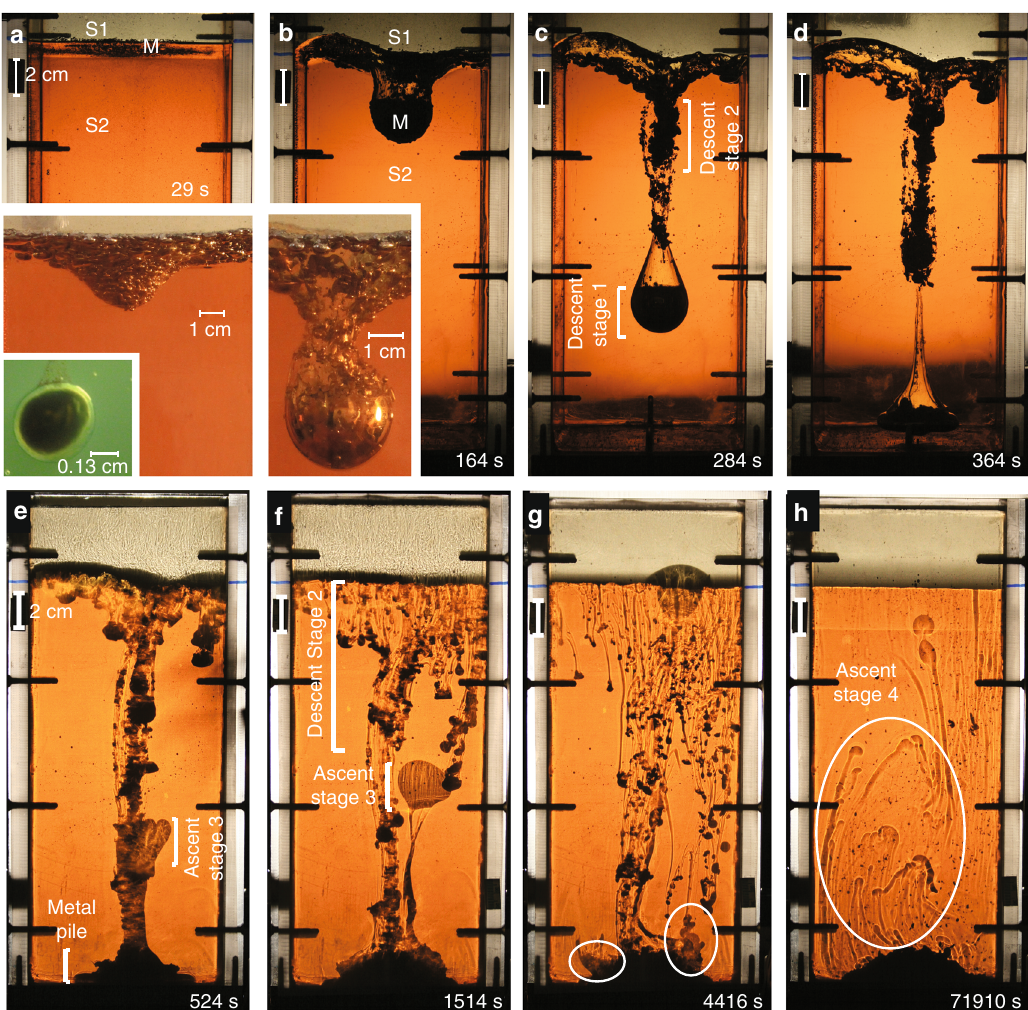
Fig. 2 Descending metal diapir. a Starting conditions of a thin emulsi fi ed gallium layer resting at the interface between two glucose layers, S 1 − S 2 (marked by a black tick mark on right side of tank). Upper inset: (orange light) A close up of the gallium (metal) layer, M, going unstable (photographed using a spotlight). Lower inset: (green light) Close up of the S 1 fi lm layer surrounding a metal droplet. b A diapir forms (stage 1) and a conduit develops. (Inset) Descent of stages 1 and 2 metal droplets. The droplets at the nose of the diapir coalesce due to shear stresses and form a smooth outer surface. It is unclear whether droplets within the diapir coalesce, due to the lack of visibility through the opaque metal. c A second stage of metal droplets descend behind the large diapir. Descent stage 2 is not observed in the case of a smooth metal pond (Fig. 1b). d Metal diapir reaches the base of the tank. Photographs a – d (Exp. 14 listed in Table 1) are taken in plain light. e A soliton forms at the base and is forced out of the conduit (shadowgraph). In the case of a smooth metal diapir (Fig. 1b) conduit material travels both downwards and upwards within the conduit. f The chemical plume (stage 3) is fully developed and travels vertically upward. Note the S 1 − S 2 interface is now fl at. g The chemical plume reaches the surface. At the base of the tank, the last, stage 4, of phase separation begins (white circles) between the S 1 fl uid and liquid metal pile. h S 1 fl uid segregates from the pile of metal droplets (20 – 30 h later) forming chemically buoyant plumelets. The diameter of each descending and rising plume head is governed by the density and viscosity ratios of the boundary layer and ambient fl uid. Thus, the formation of the fi rst large chemical plume is likely the maximum diameter for this viscosity ratio, but the small plumelets fall below this threshold. Fig. e – h (Exp. 14) are Conduit behavior . To study the formation of a conduit, we around a perfect sphere during descent, but will be reduced if measure the change in average conduit radius versus time for the obstructed by the presence of a conduit on the trailing side of the case of a smooth metal pond (Fig. 4c) and the case of an emul- sphere. The last term considers the mass of a trailing conduit si fi ed metal pond (Fig. 4d). Three distinct slopes indicate three (where r c is conduit radius) and h c is conduit height. The regimes of conduit behavior for the case of a smooth metal dia- theoretical prediction given by Eq. (2) is shown in Fig. 4b (dashed pir 50 (Fig. 4c). In regime 1, conduits form as the metal diapirs lines). The departure of the diapir velocity from classical Stokes descend. Conduit radius, governed by the leading metal diapir, is velocity (solid lines) increases systematically with h m (which largest when the metal diapir fi rst forms (Fig. 1b), and decreases indirectly increases diapir radius, r m , once the metal pond goes in radius rapidly as it sinks to the base. Regime 2 marks conduit unstable). Close fi t with the theoretical prediction suggests that collapse due to the reversal of conduit material as S 1 fl uid rises up the increase in conduit radius (represented by θ ), which forms buoyantly through the conduit after the metal diapir reaches the behind each descending diapir, is the dominant factor controlling base (open square) and stops sinking. The collapse rate is higher descent velocities.